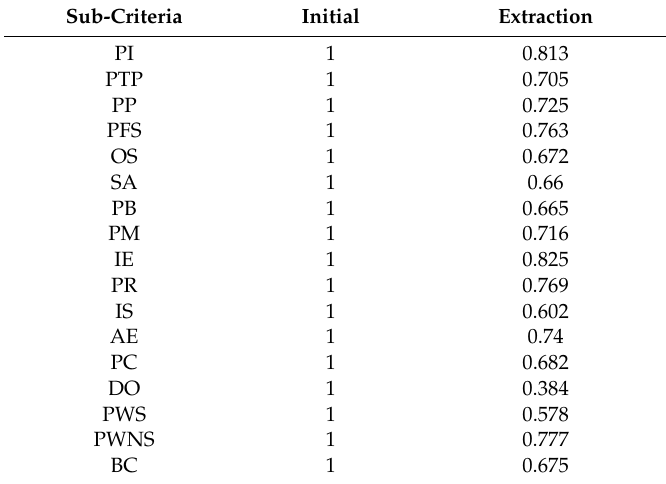
Table 4. Communities of the seventeen evaluated criteria of FA